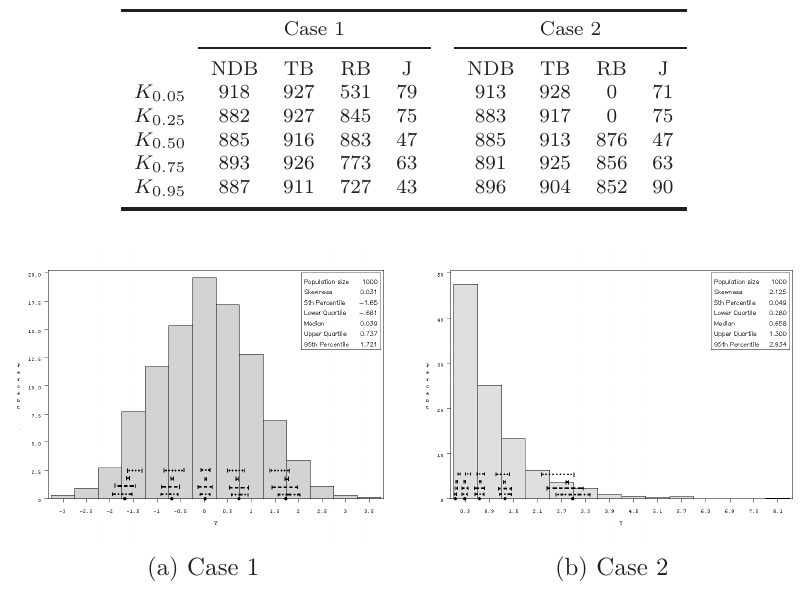
Figure 5. The averages of the estimated confidence intervals.